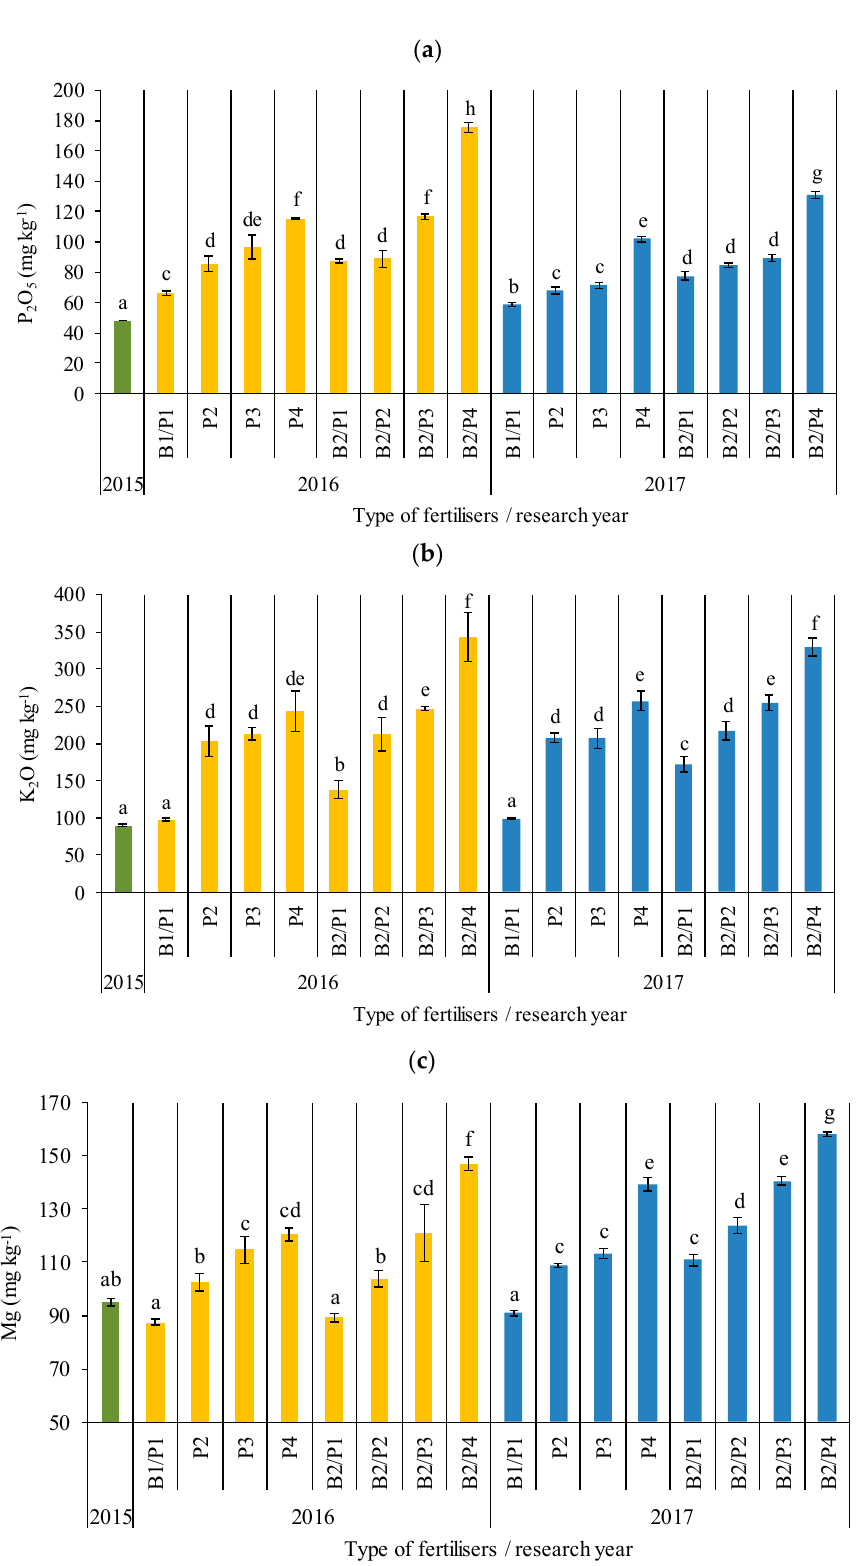
Figure 2. Contents of absorbable forms of phosphorus P 2 O 5 ( a ), potassium K 2 O ( b ) and magnesium Mg ( c ) in the soil prior to the experiment (2015) as well as following the first and the second year of cultivation, in relation to the type of fertiliser applied. The mean values marked with the same letter do not differ significantly at a level of α ≤ 0.05 based on the results of the Bonferroni test.